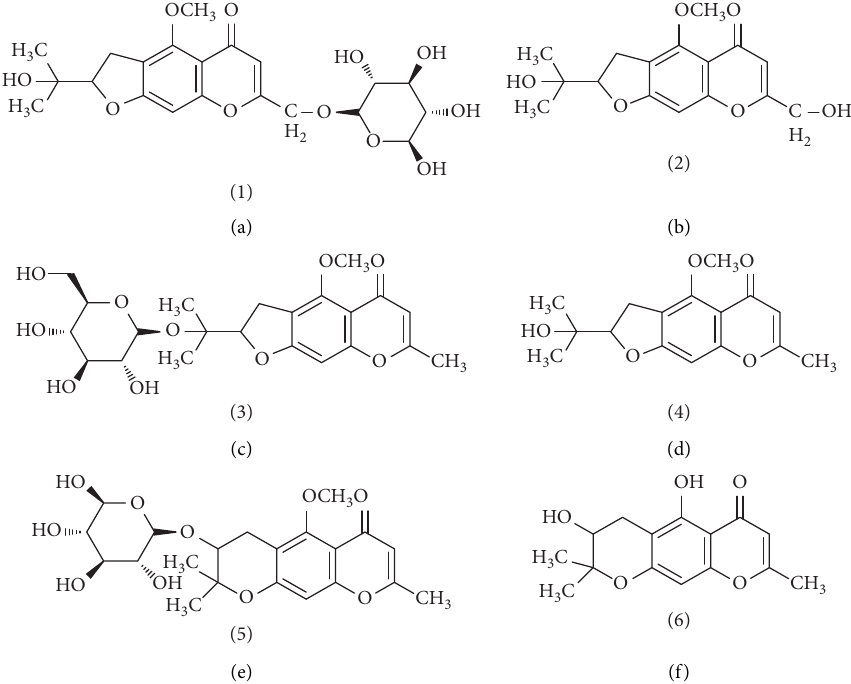
Figure 1: Chemical structures of prim-O-glucosylcimifugin (a), cimifugin (b), 5-O-methylvisammioside (c), 4 ′ -O-D-glucosyl-5-O- methylvisamminol (d), sec-O-glucosylhamaudol (e), and hamaudol